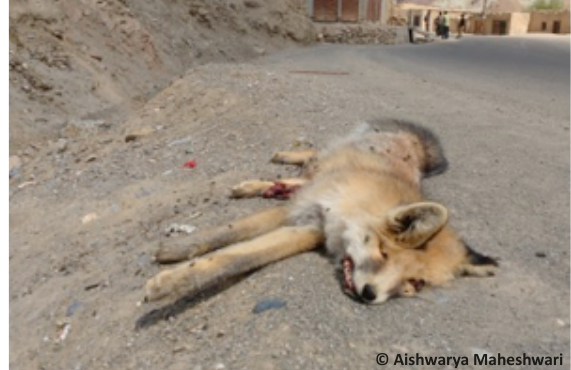
Image 2. Red Fox road